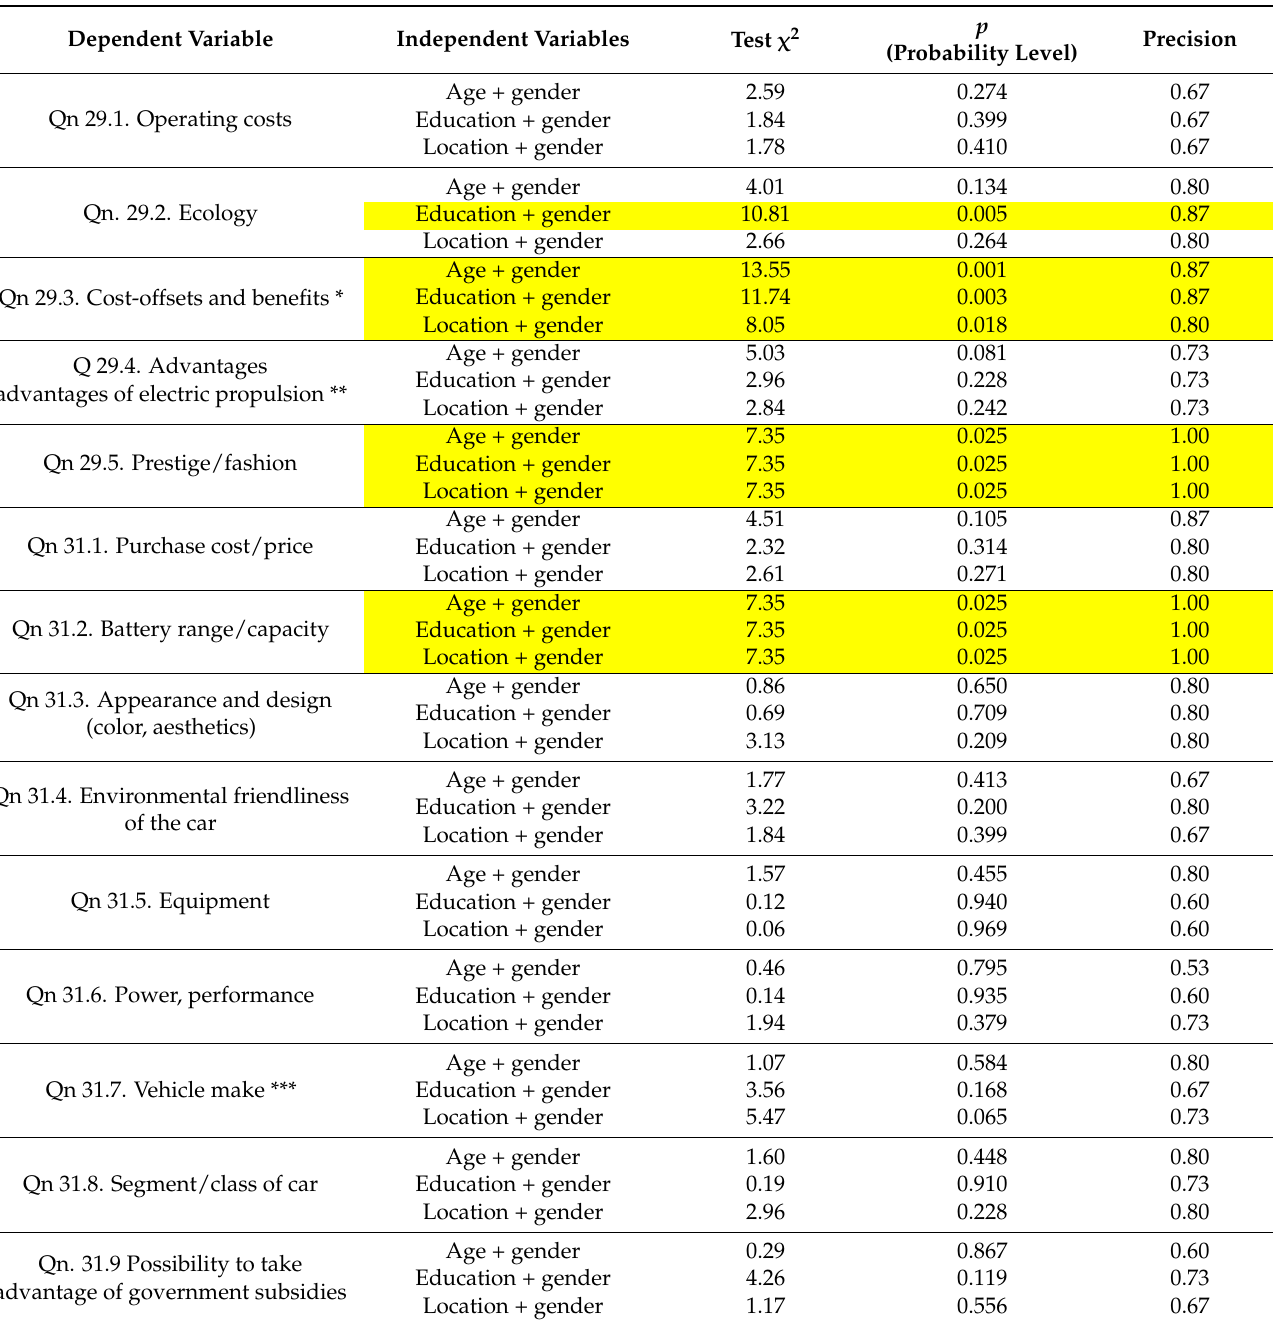
Table 8. Logistic regression results for the question about the decision to buy an electric car (for questions 29 and